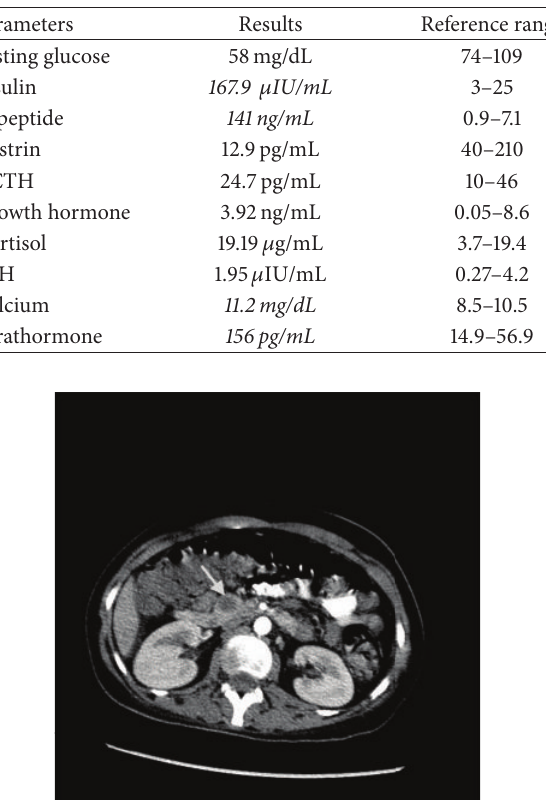
Table 1: The patient preoperative laboratory values.